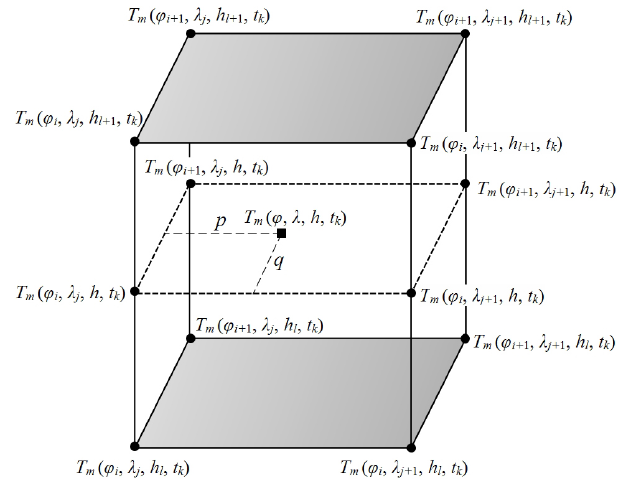
Figure 4. Spatial interpolation for the target point located at ( ϕ , λ , h) using the T m values at the eight closest voxels determined by the GWMT-D model. The first interpolation is for each of the four vertical edges of the box, and the second interpolation is on the 2-D plane at the height of the target point (the dashed